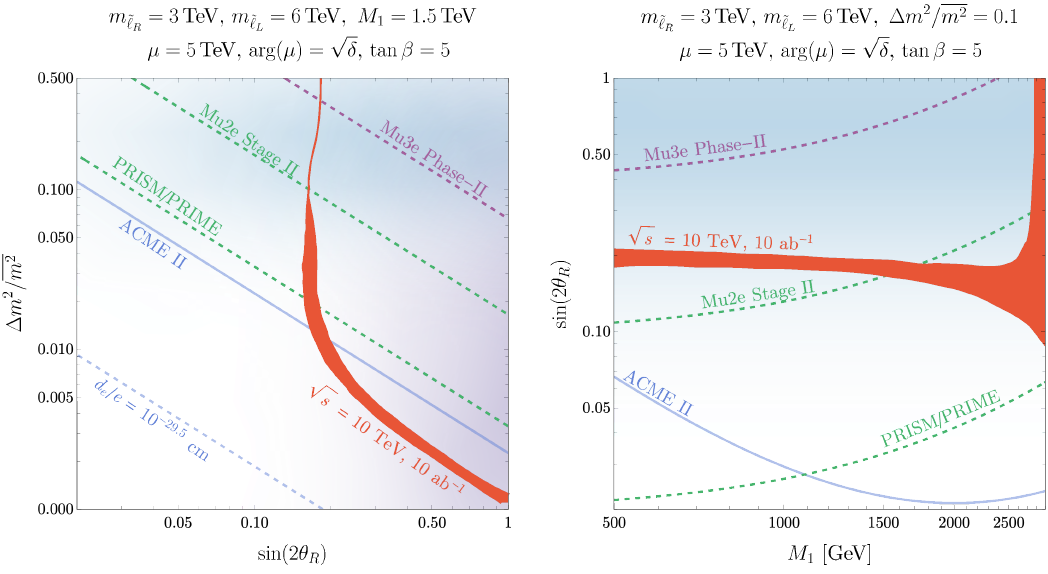
Figure 8. Complementarity of a 10 TeV muon collider with EDM and µ → eγ experiments. This figure is similar to the upper row of figure 6, but also shows the electron EDM constraint from the contributions shown in figure 7. The phase in the µ term is assumed to originate from a subdominant gravity mediated contribution of order m constraint from the current ACME II experiment [96]. The dashed blue curve shows a hypothetical (near-)future